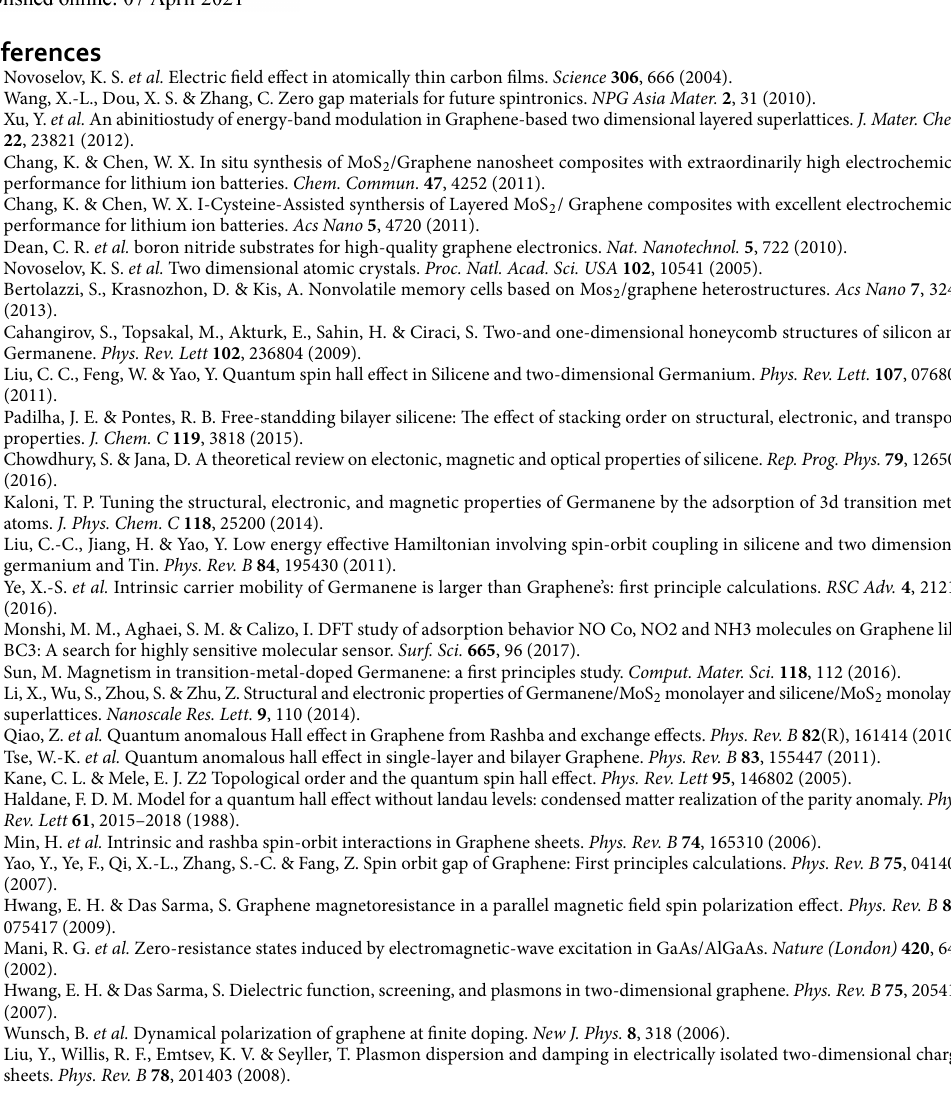
Figure 14. The transverse static spin structure factor s normalized temperature k B T / t for different values of magnetic field g µ B B / t . Spin-orbit coupling strength has 0.4 been fixed at (cid:31) / t =